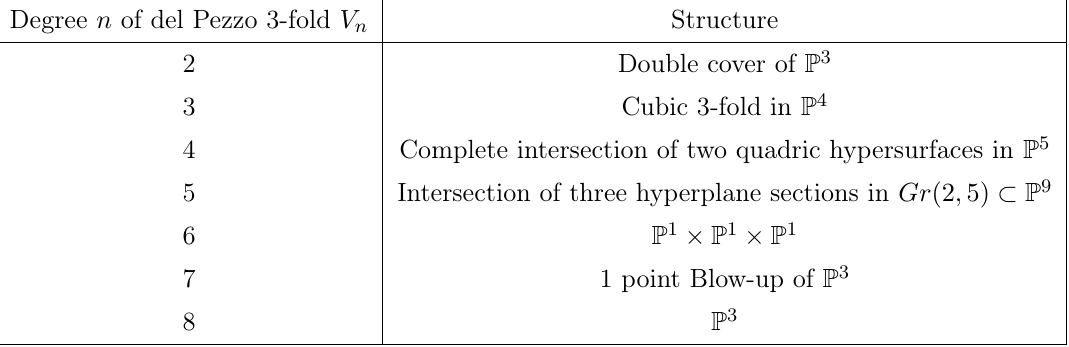
P 3 embedded 8 of degree 8 is the image of